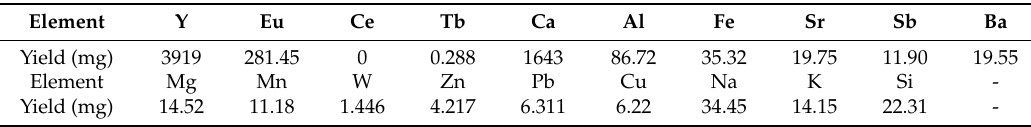
Table 2. Inductively coupled plasma (ICP) emission spectroscopy analysis of the dissolved solution by leaching 20 g waste fluorescent